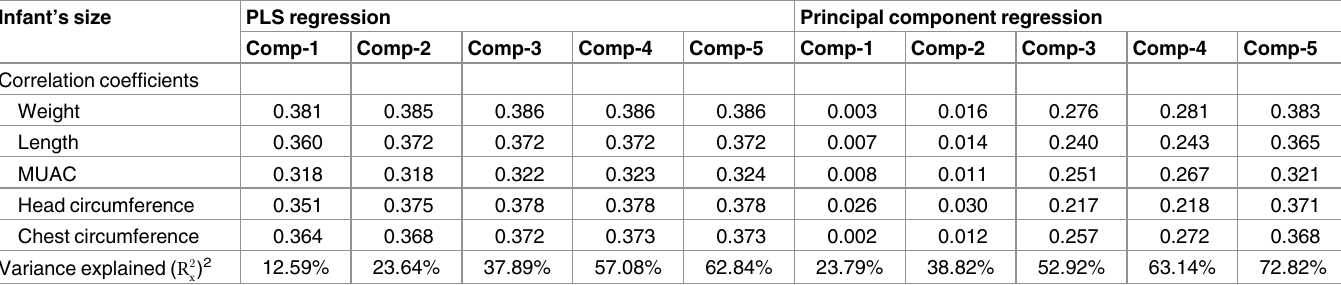
Table 3. Coefficients of Pearson’s correlation between the predicted values of birth size (by PLS and principal component regression) and observed values and the varianceof the maternal and infant characteristics explained by the components of PLS and principal component regres- sion